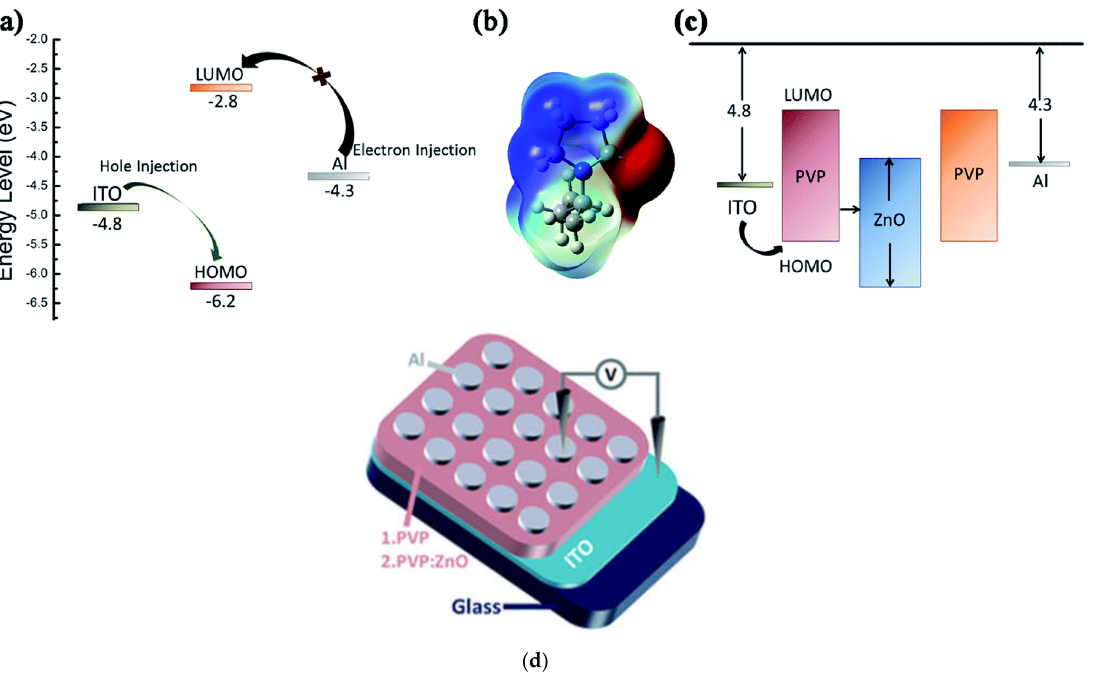
Figure 5. ( a ) Energy level diagram of the devices that are based on PVP. ( b ) The electrostatic poten- tial (ESP) of the molecule as determined using DFT. ( c ) Illustration of the energy bands of the ITO/PVP:ZnO/Al device. ( d ) Schematic structure of resistive random-access memory (RRAM) de- vice based on polyvinylpyrrolidone (PVP) and PVP:PVP:zinc oxide nanoparticle (ZnO NP) active layers [217].